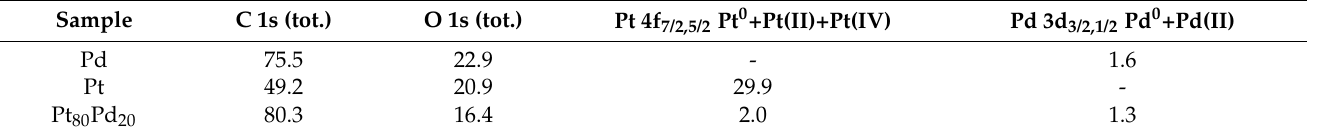
Table 2. Composition of the surfaces of the NPs-GP systems obtained by XPS (atomic concentration %). Sample C 1s